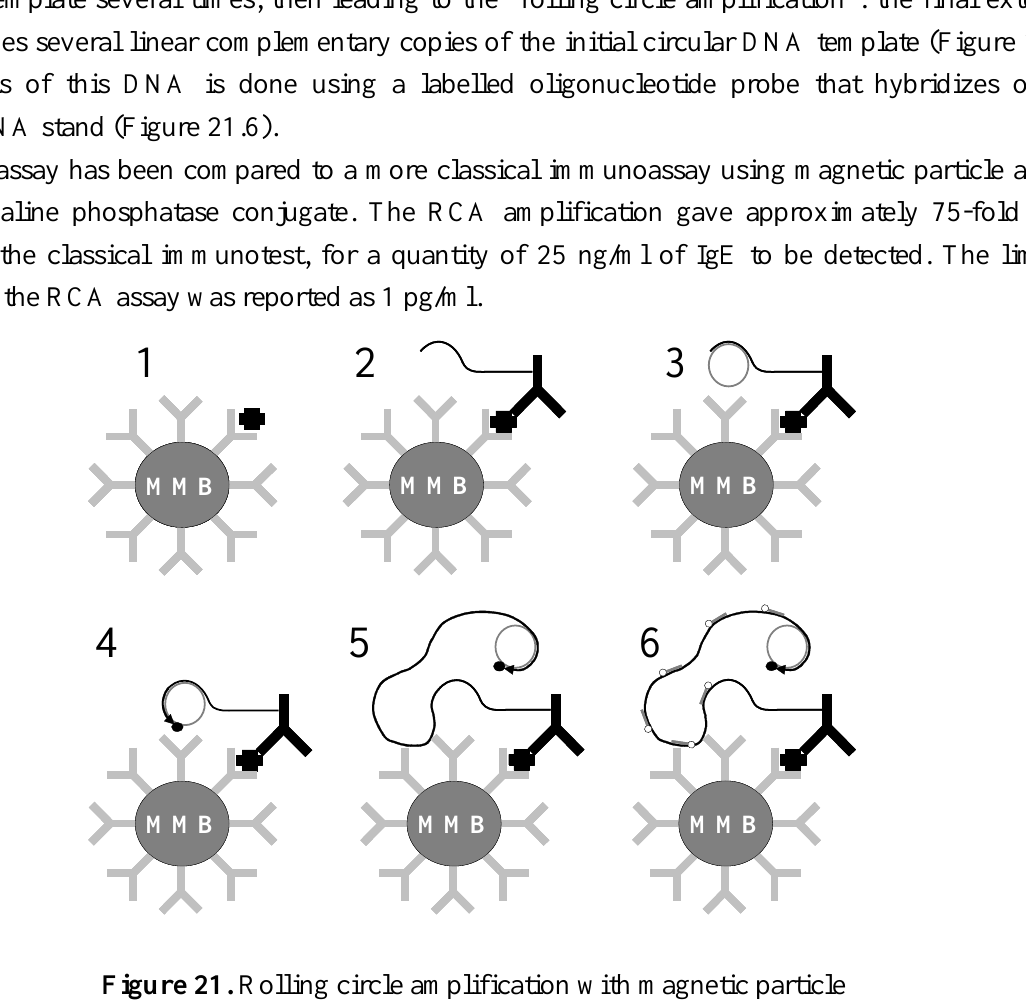
Figure 21. Rolling circle amplification with magnetic